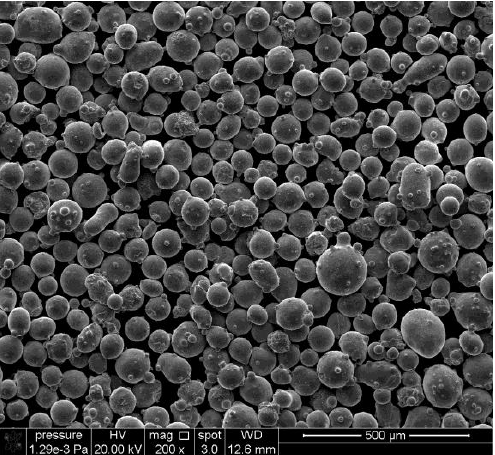
Figure 1. Morphology of the Ni-based alloy powder for laser cladding. Table 1. Chemical composition of the powder and substrate (wt %).